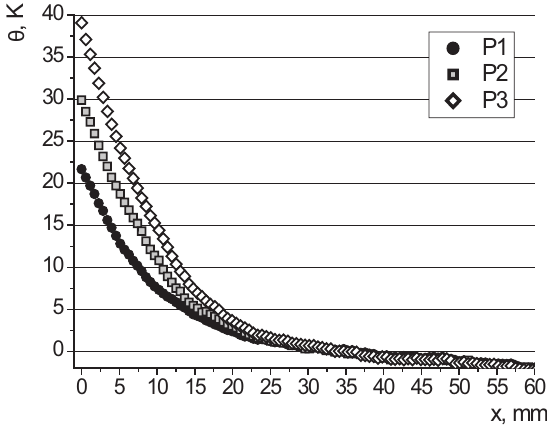
Figure 5. Temperature distribution along the fin for three levels of electric power (P) supplied to the main heater: metal – fibrous sample of 67% porosity; distilled water boiling